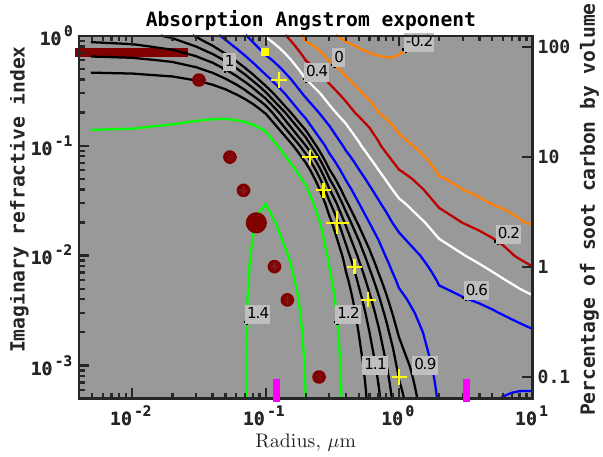
Figure 2. AAE (440–870) contours for lognormal particle size dis- tributions with refractive index n = 1 . 49 and mode width σ = 0 . 38. Shaded maroon rectangle at the top of the plot indicates range of values for externally mixed sC using primary spherule sizes (radii (cid:46) 0 . 025µm); the yellow square corresponds to externally mixed sC with a median radius of 0.1µm. Symbols indicate inter- nal mixing of 0.025µm (circles) or 0.10µm (“ + ”) sC with scatter- ing aerosols for sC volume fractions of 0.1, 0.5, 1, 2.5, 5, 10, and 50 percent. The black lines denote AAE = 1 ± 0 . 1. Magenta ticks located at R = 0 . 12 and 3.2µm are typical fine and coarse mode median radii in the AERONET